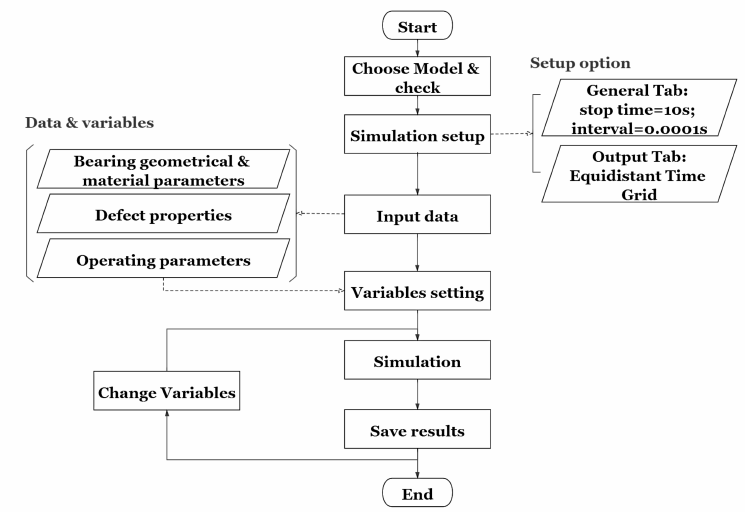
Figure 4. Simulation flowchart with virtual bearing test bench in Modelica